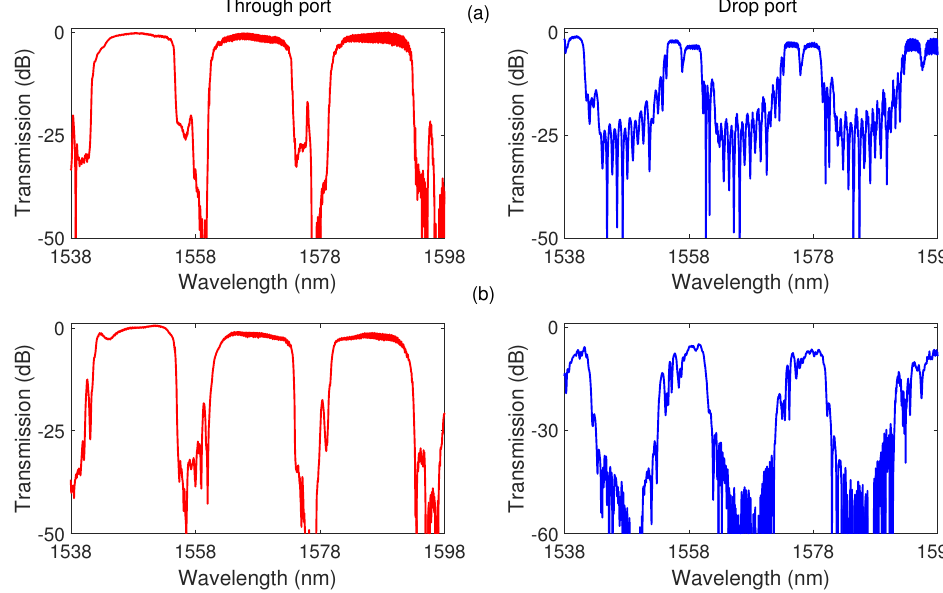
Figure 6. Measured transmission spectra of the through ports and drop ports at different resonance wavelengths for the ( a ) 1 × 20 arrays and the ( b ) 3 × 20 arrays.